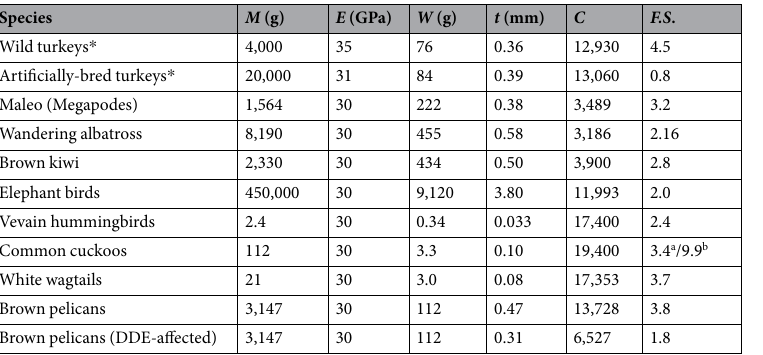
Table 3. Summary of case studies. * Experimental results. a Incubated by cuckoos; b Incubated by the host (white